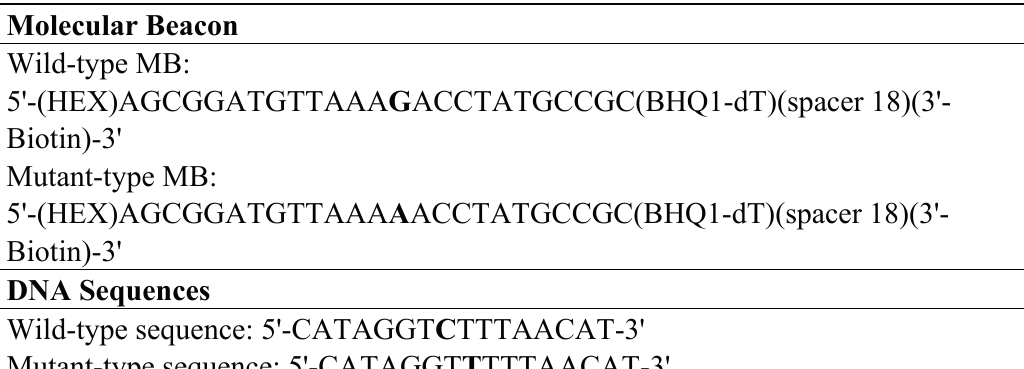
Table 1. Molecular beacons and DNA sequences used for testing the immobilized SCF. Samples were synthesized by the Midland Certified Reagent Company Inc. Concentration of DNA solution used in the hybridization experiment is 100 nM.